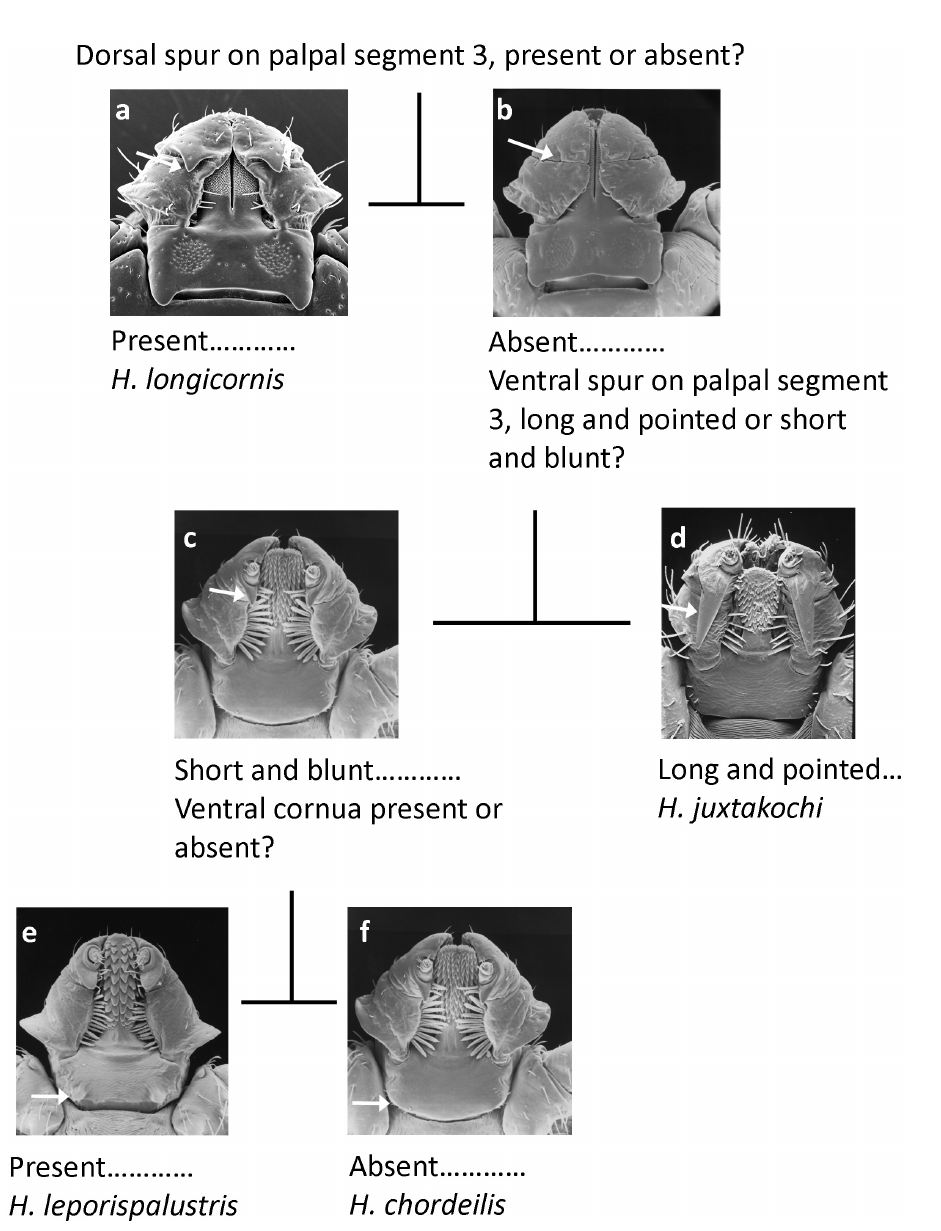
Figure 5. Pictorial key to adults of Haemaphysalis spp. occurring in North